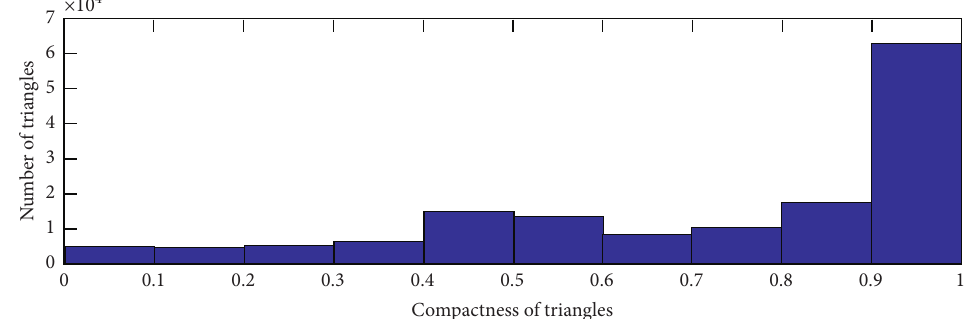
Figure 3: The compactness of the original surface of Bimba point